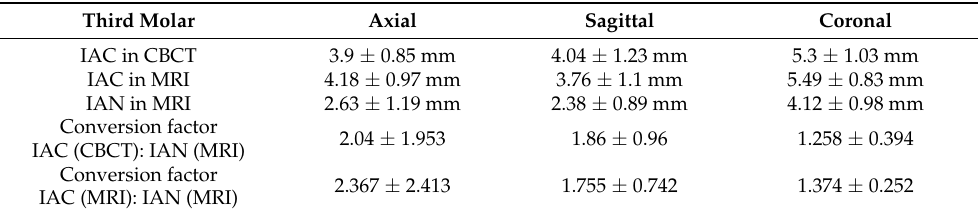
Table 4. The maximal diameter expansion of the IAC in CBCT and in MRI and the IAN in MRI was determined in the axial, sagittal, and coronal plane at the level of the third molar. A conversion factor between IAC and IAN using the two imaging modalities was